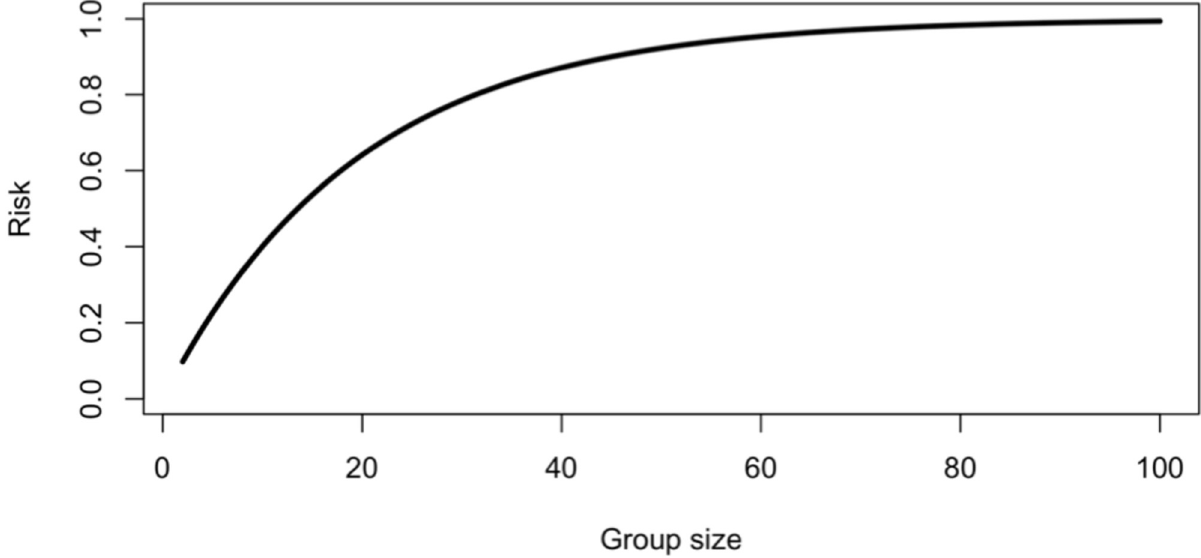
Fig 1. The risk of groups of different sizes (Eq 3) when the true fraction of infected individuals is f can be used to determine the risk associated with groups of different sizes (ranging from 2 to 100) by choosing a group size on the x-axis, drawing a vertical line to intersect the curve, drawing a horizontal line that intersects the y-axis, and reading off the level of risk.